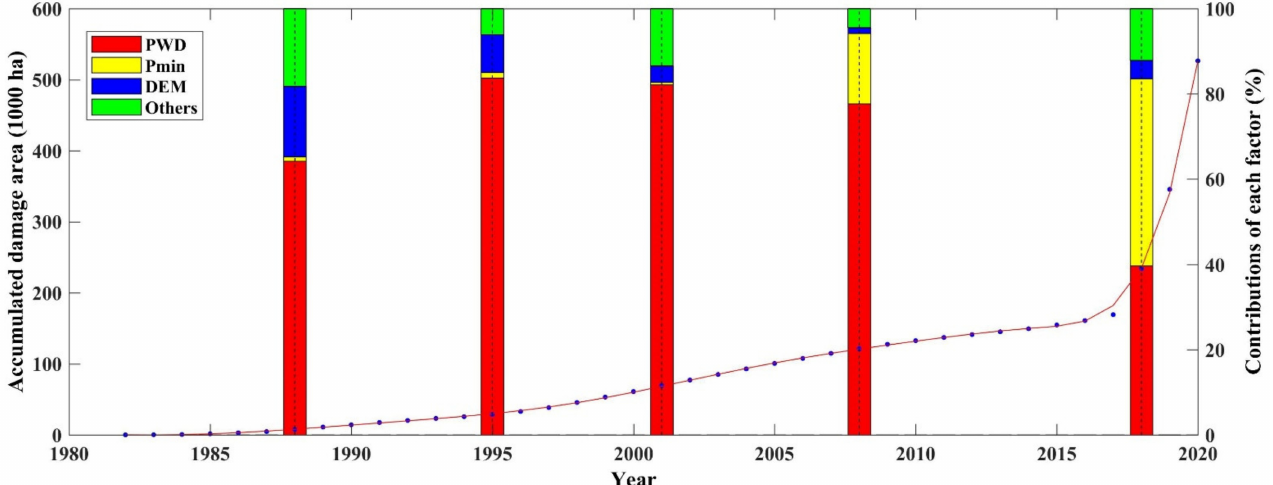
Figure 2. Temporal changes in the cumulative forest areas damaged by PWD in China from 1982 to 2020. The time series of cumulative damaged areas was divided into six intervals with piecewise polynomial fitting. The contributions of the three most important factors, namely, PWD (the PWD distribution in the previous year), Pmin (Bio14: the total precipitation during the driest month), and DEM, in outbreak years (1988, 1995, 2001, 2008, and 2018), to the accumulated damage area are presented in the stacked bar